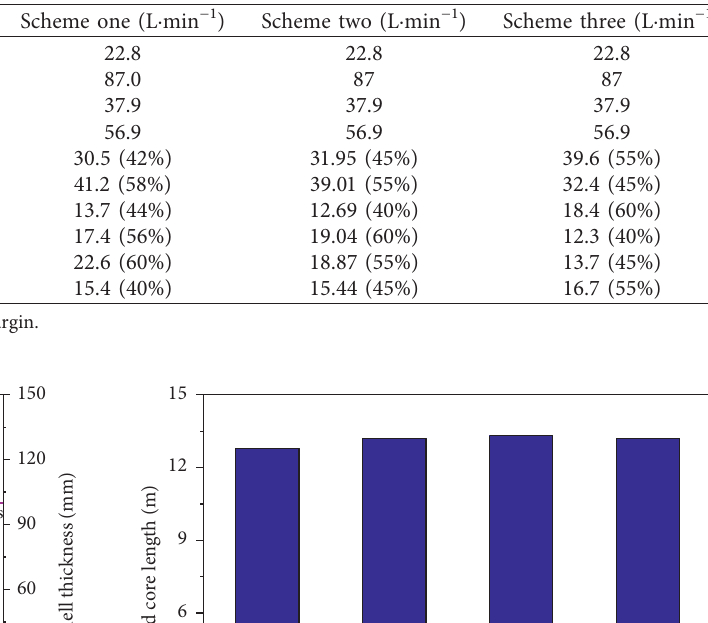
Table 4: Distribution of water under different water distribution schemes.